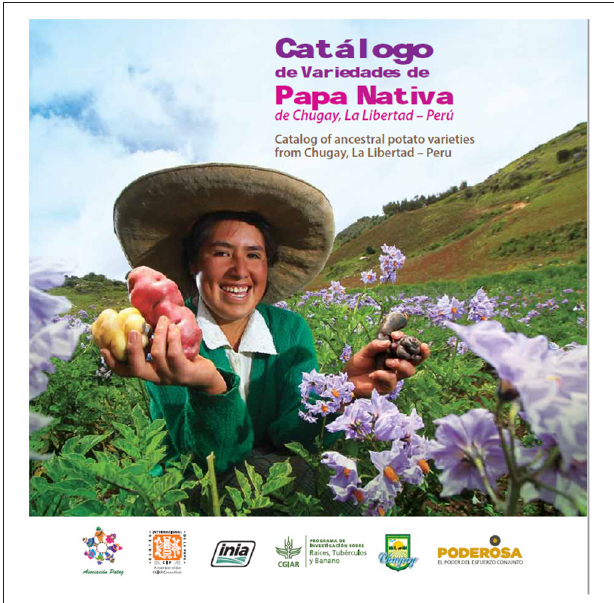
FIGURE 1 | An example of a published community landrace diversity inventory for the district of Chugay, Sánchez Carrión province, La Libertad department Peru ( Centro Internacional de la Papa (CIP) et al., 2015). Baseline-level documentation of crop diversity and associated knowledge is intended to facilitate agrobiodiversity monitoring, geographical indication, biodiscovery, and local education. Image by Asociación